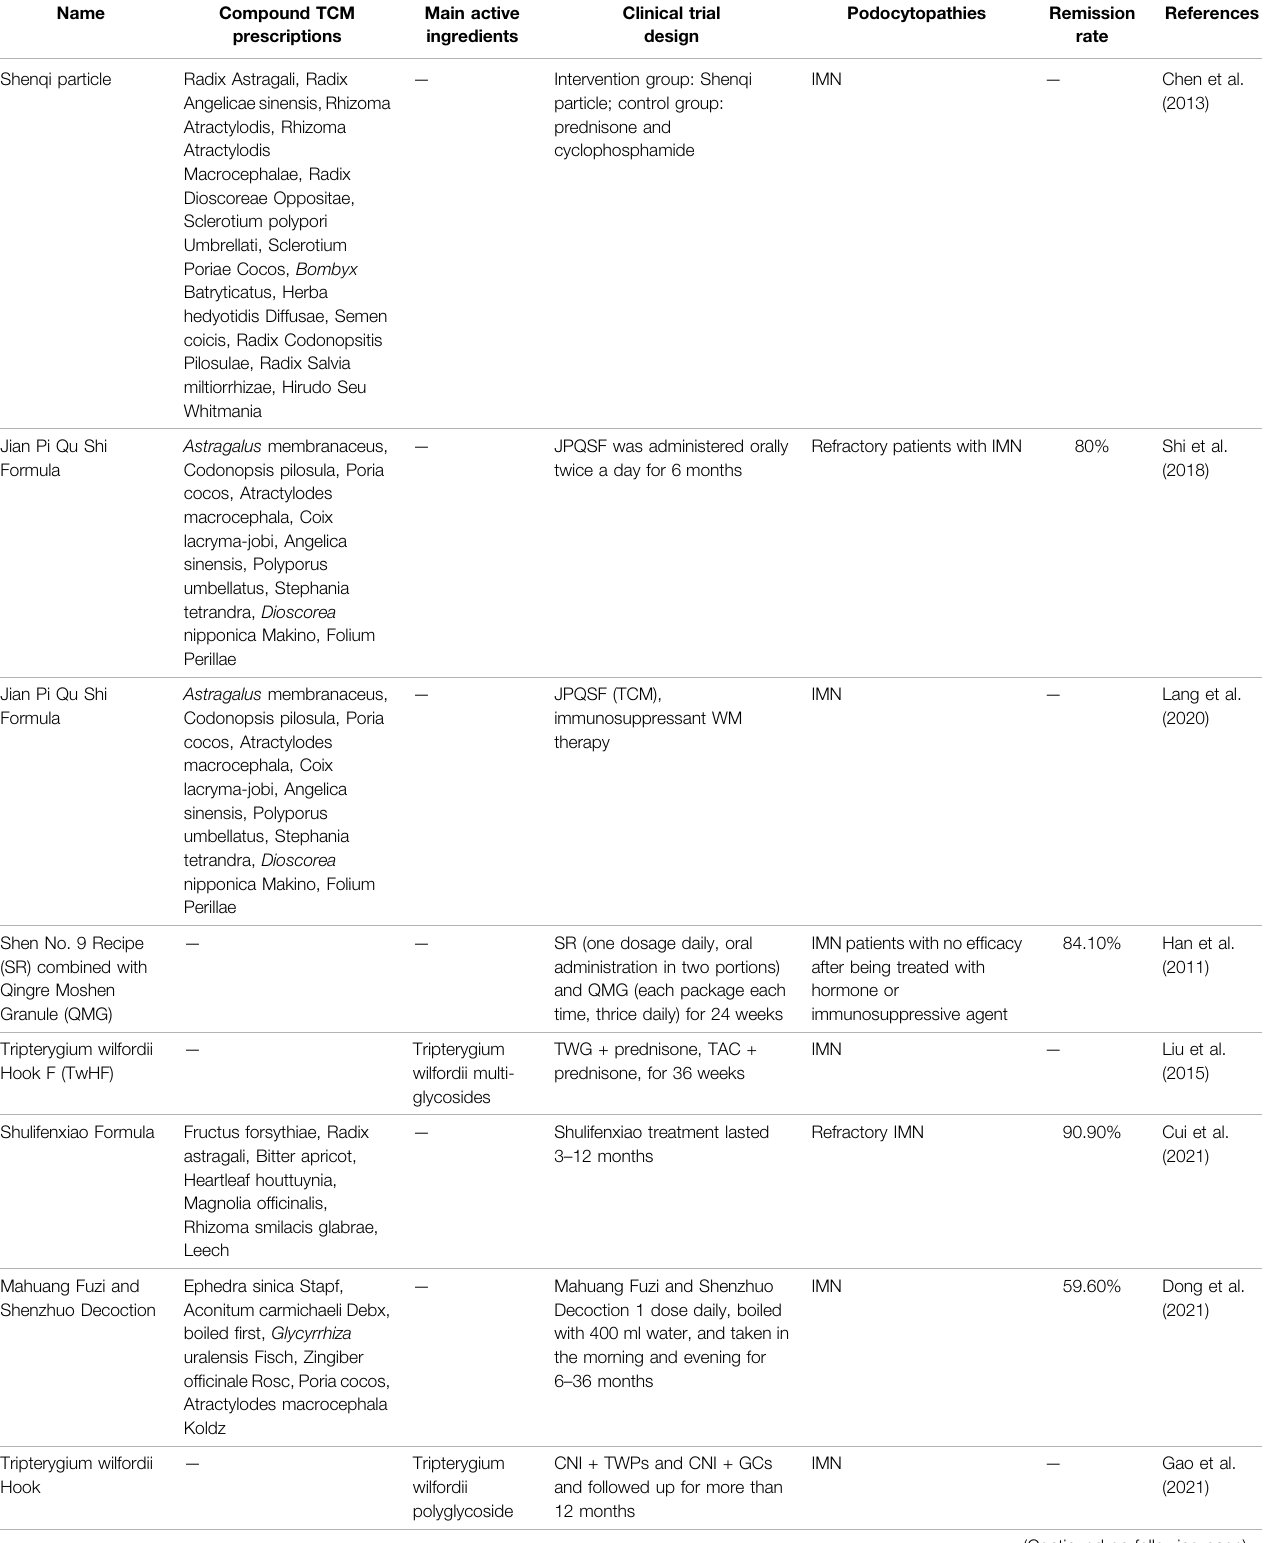
TABLE 2 | Clinical studies on treating podocytopathies with TCM.